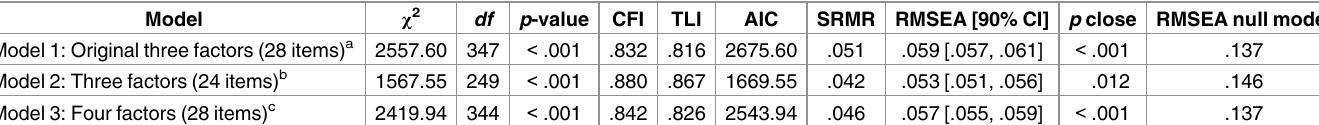
Table 1. Summaryof fit indices for measurement models.